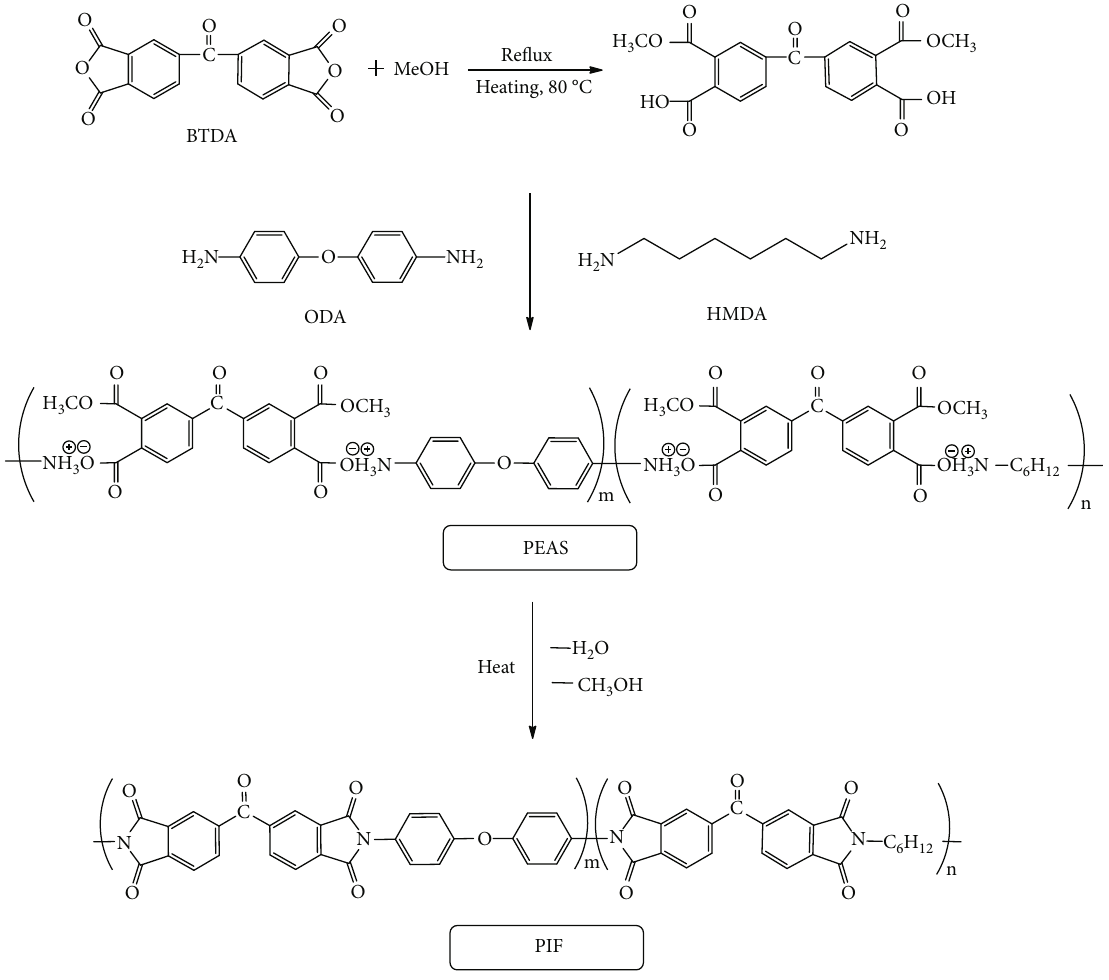
Scheme 1: Synthesis of PIFs with ODA partially replaced by HMDA. Table 1: Compositions of BTDA/ODA-HMDA based polyimide foams (PIF-mol% refers to mol% of HMDA in